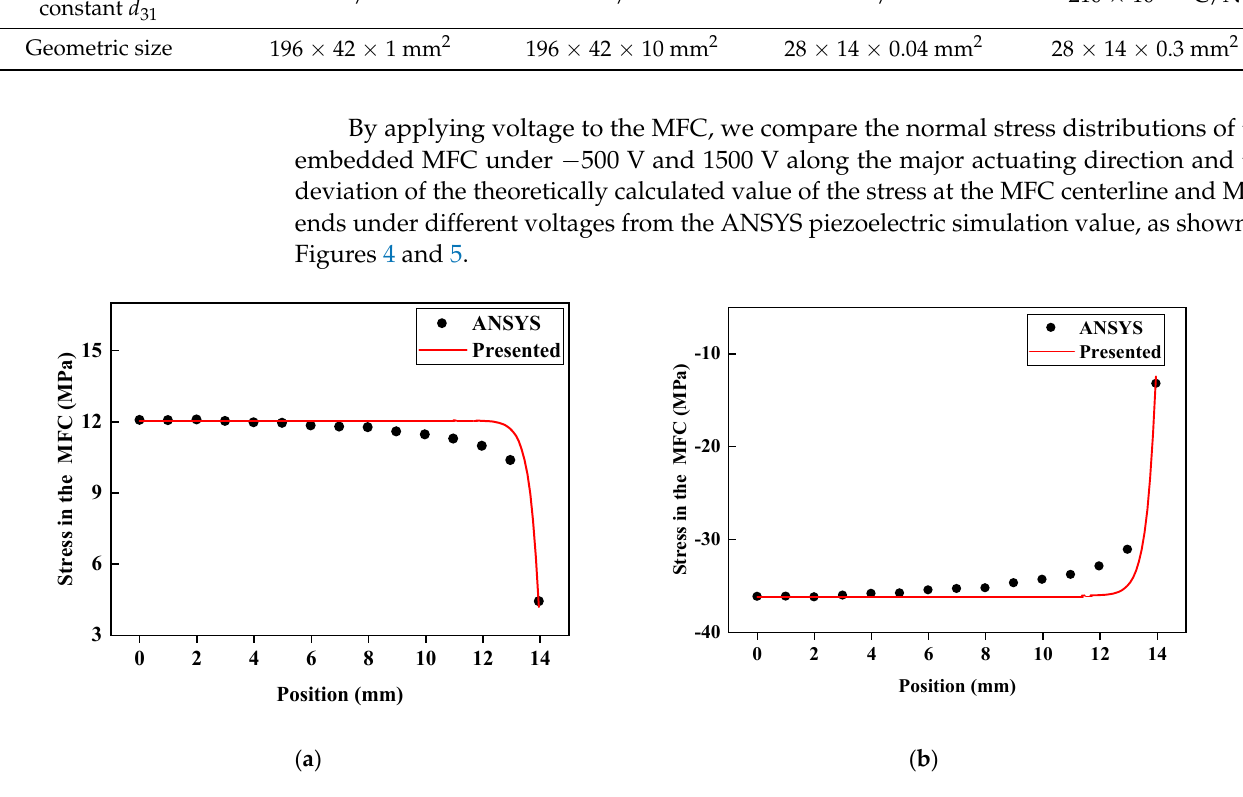
Figure 4. Normal stress distribution of MFC along the actuating direction: ( a ) − 500 V; ( b ) 1500 V.